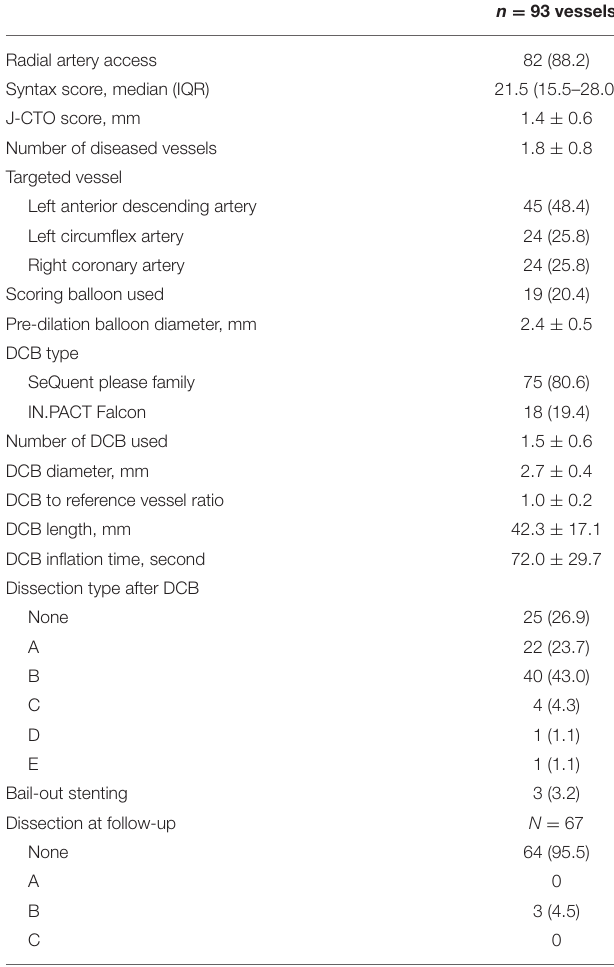
Table 2 summarizes the angiographic and procedural